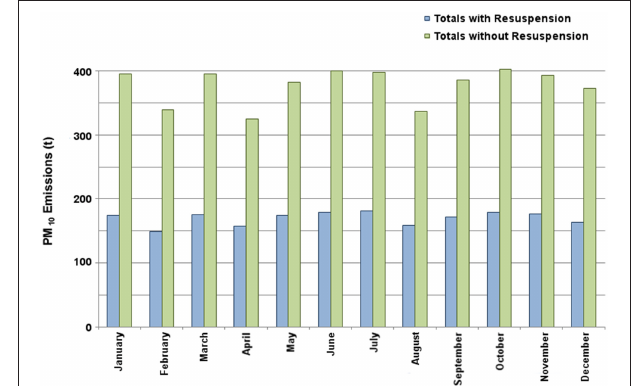
FIGURE 5 | Monthly comparison of PM 10 emissions for the Madrid Region with and without traffic-induced resuspension.